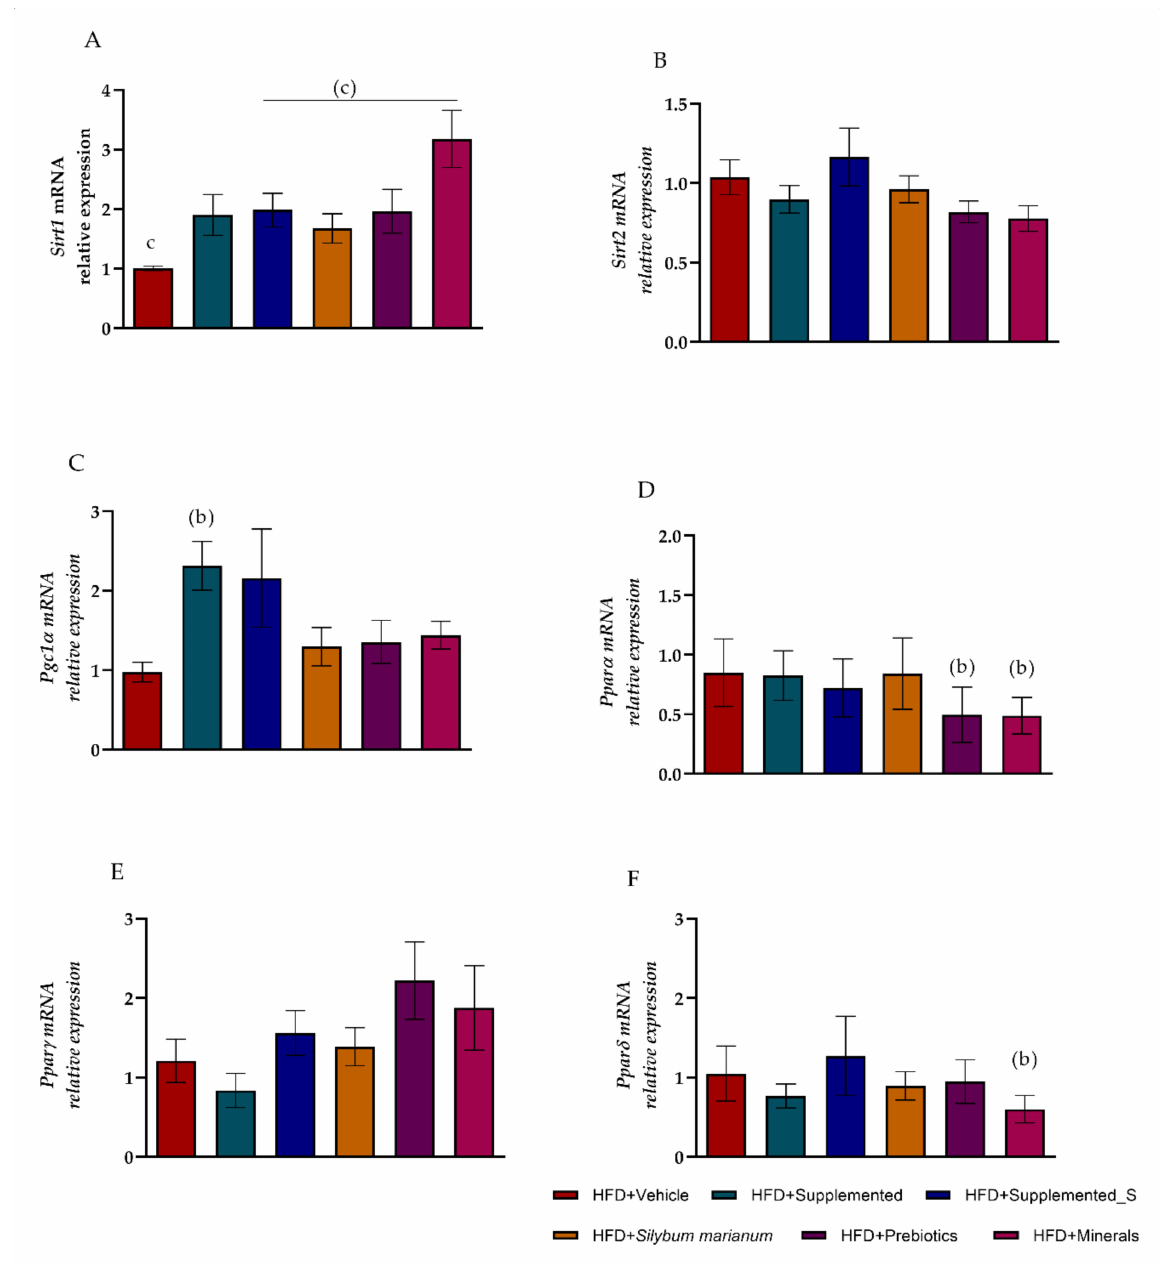
Figure 7. Liver mRNA expression is determined by quantitative PCR. Differences were seen in: ( A ) Sirt1 ; ( B ) Sirt2 ; ( C ) Pgc1 alpha ; ( D ) Ppar α ; ( E ) Ppar γ ; ( F ) Ppar δ . Significant p < 0.05 in one-way ANOVA followed by Tukey’s (parametric) ( A – C , E , F ) or Müller Dunn’s (nonparametric) ( D ) post-hoc test (n = 4–8 per group). Means and standard deviations were used to generate the effect size estimates (Hedge’s g): (b) versus HFD + Vehicle; (c) versus HFD + Supplemented. HFD = high-fat diet. Values are means ± SD. The housekeeping gene was Gapdh. Values are means ±